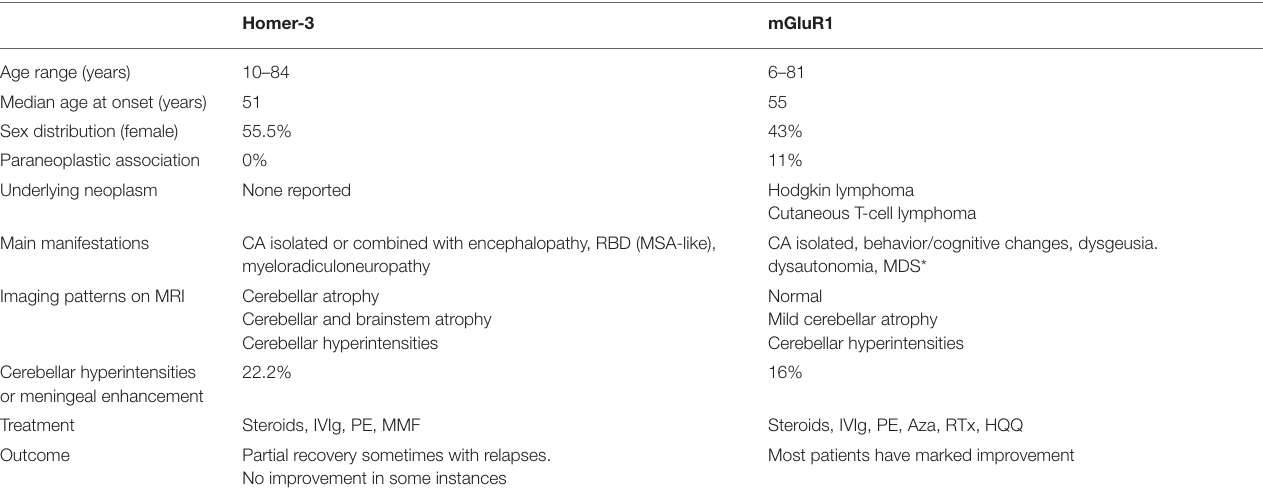
TABLE 2 | Differences between Homer-3 and mGluR1